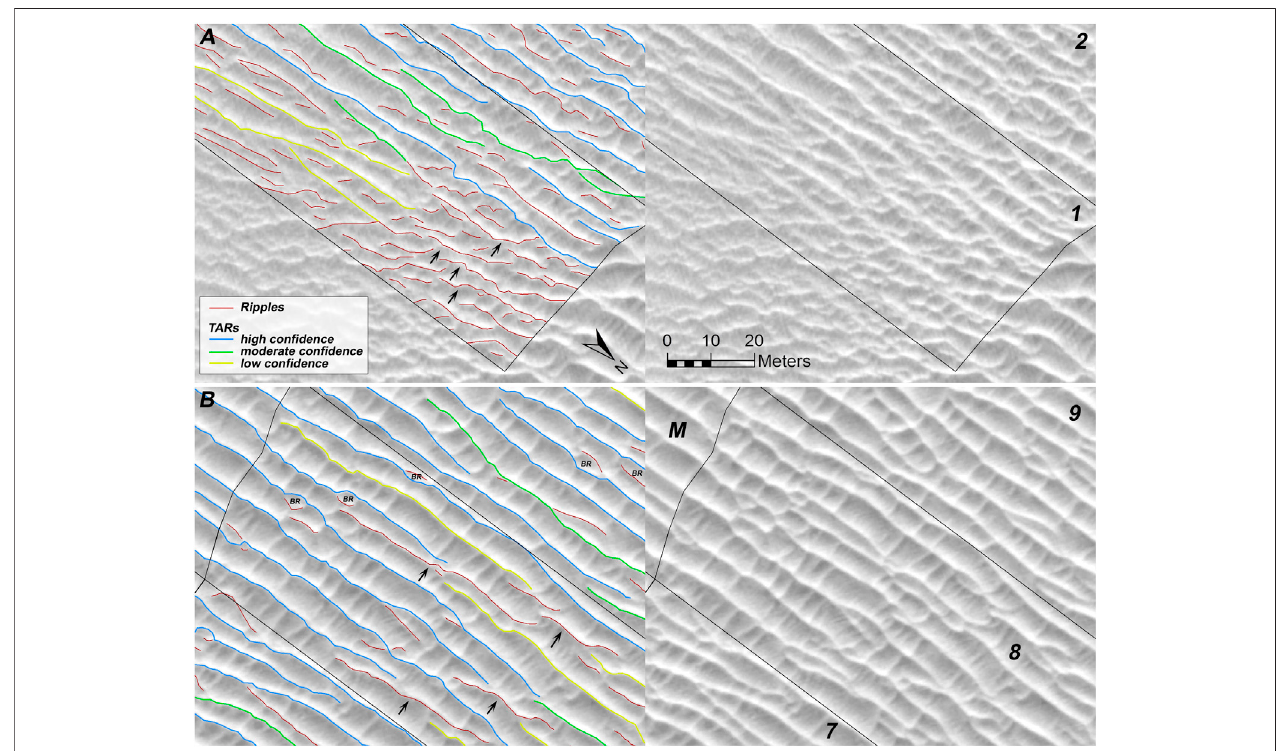
FIGURE 8 | Ripples and TARs (A) just upwind of Dune A and (B) farther upwind in the Dune A wake, shown with and without mapped crestlines (orthorecti fi ed HiRISE image ESP_044722_2570). Numbers correspond with wake segments, the mature region is labeled M , arrows indicate ripples that superpose TARs, bedform repulsions between TARs and ripples are labeled BR